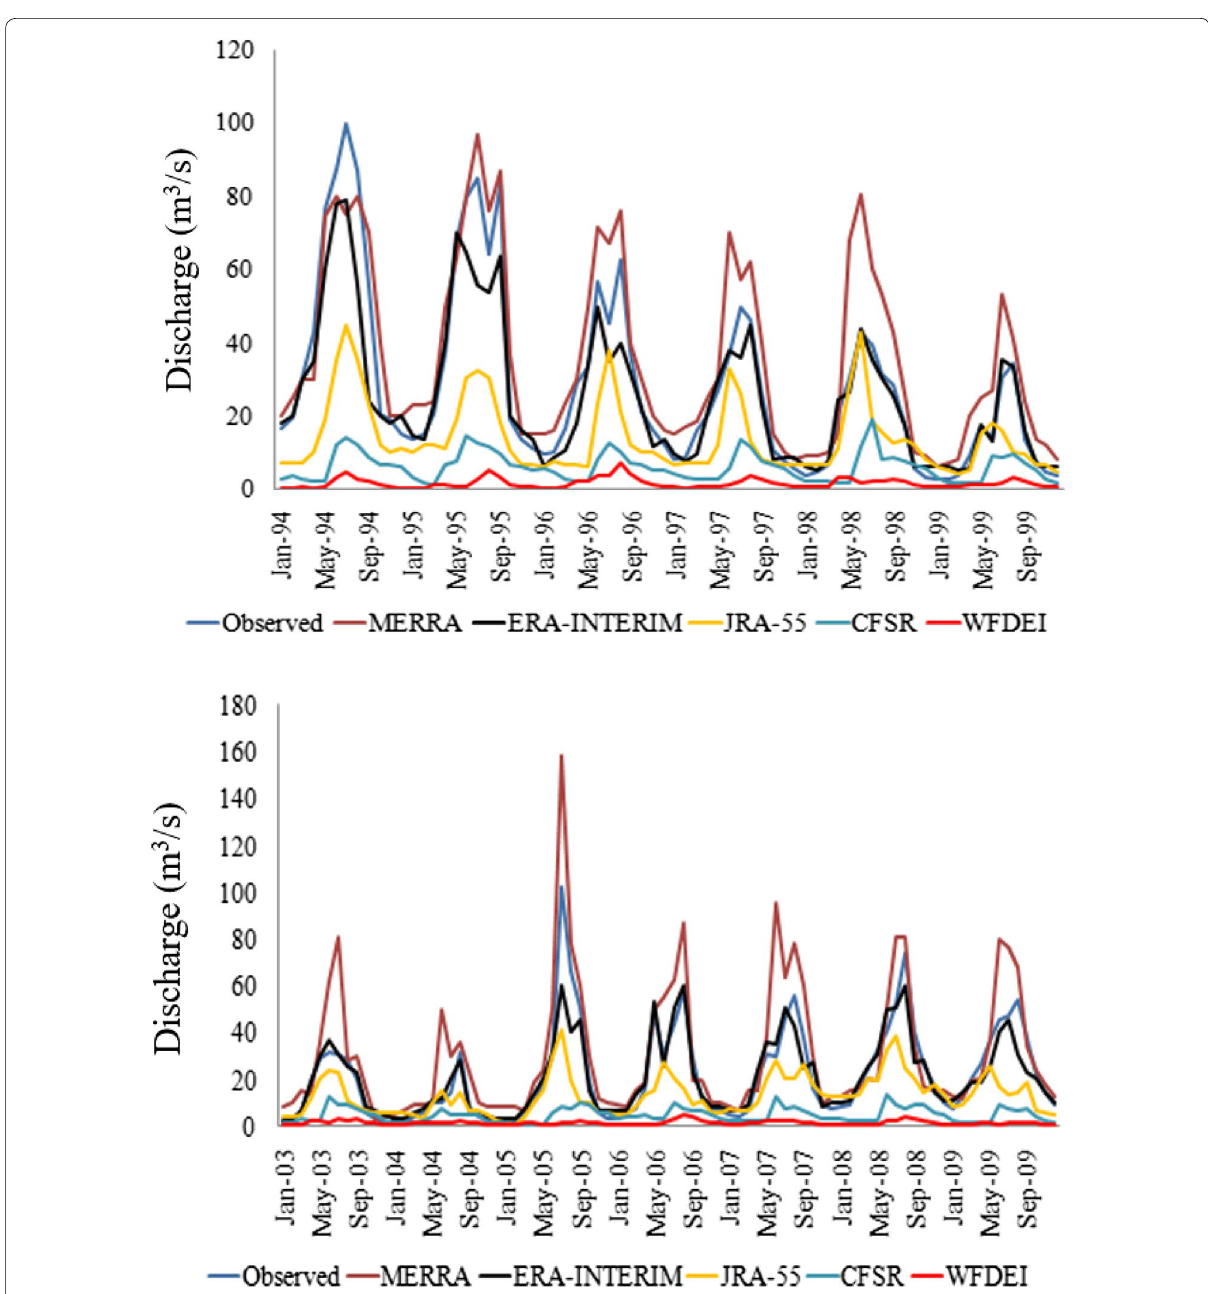
Fig.17 Hydrograph of observed and simulated flow of Manali for calibration period (1994–1999) and validation period